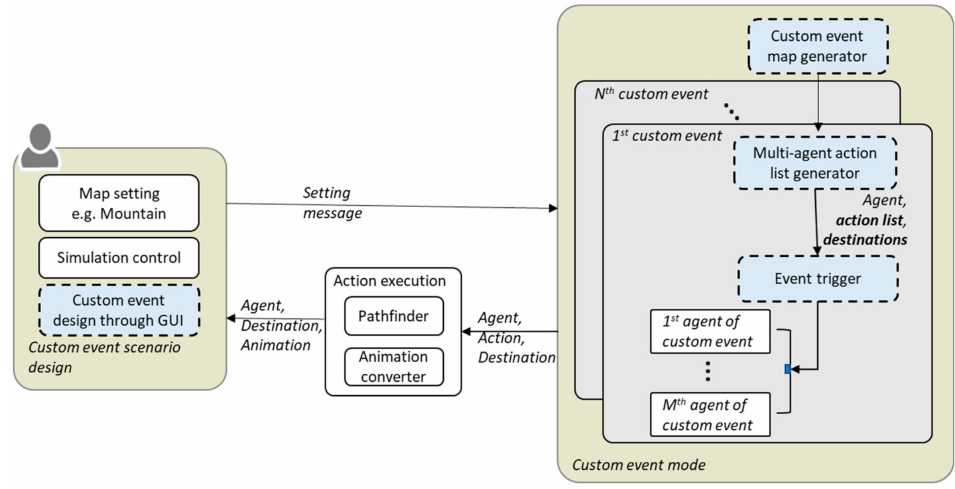
Figure 5. Overview of the custom event